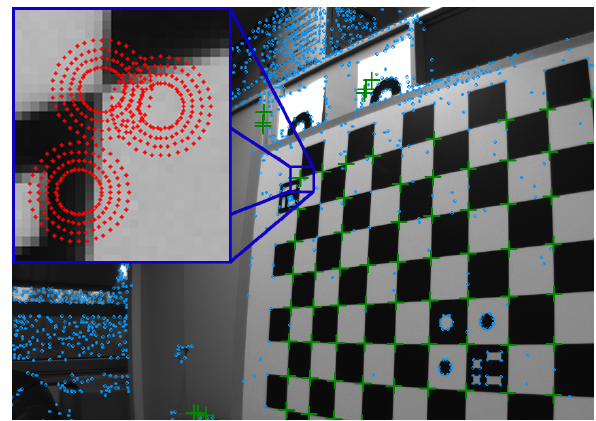
Figure 2: Selected corners by AGAST (blue dots) and verified corner points (green crosses) in an image with visible office back- ground. Top-left: Grey value sample locations for the verification at the example of three AGAST